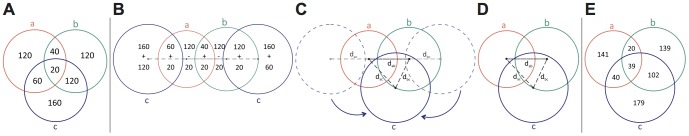
A method for constructing an area-proportional 3-Venn diagram using circles.(A) The quantitative values in each region indicate the required region areas, for which an area-proportional 3-Venn diagram should be drawn. (B) The first step of the construction whereby the three accurate 2-Venn diagrams are drawn. (C) The second step of the construction whereby the identical copies of the circle labelled c are rotated such that they overlap completely and only one circle labelled c is visible. (D) The instance when only three circles are visible, such that the regions of the 3-Venn diagram are obtained. (E) The actual area of the regions in the constructed diagram D, which, as in most cases when these diagrams are drawn with circles, do not correspond to the desired values in A. The numeric label in each region of this diagram indicates the regions' actual area.